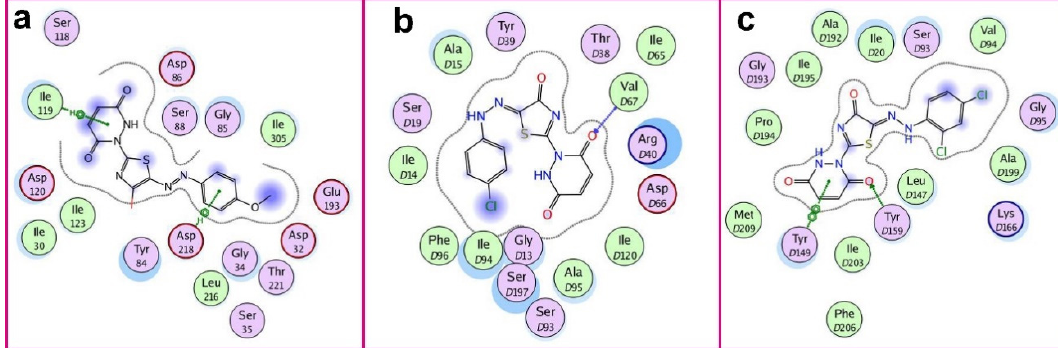
Figure 3. Ligand interaction diagrams for the best fitting ligand molecules showing the amino acid residues of the receptor active site and their interaction with the ligands. ( a ) SAP2 of C. albicans / 5d , ( b ) FabI of S. aureus / 9c and ( c ) FabI of P. aeruginosa / 9d .